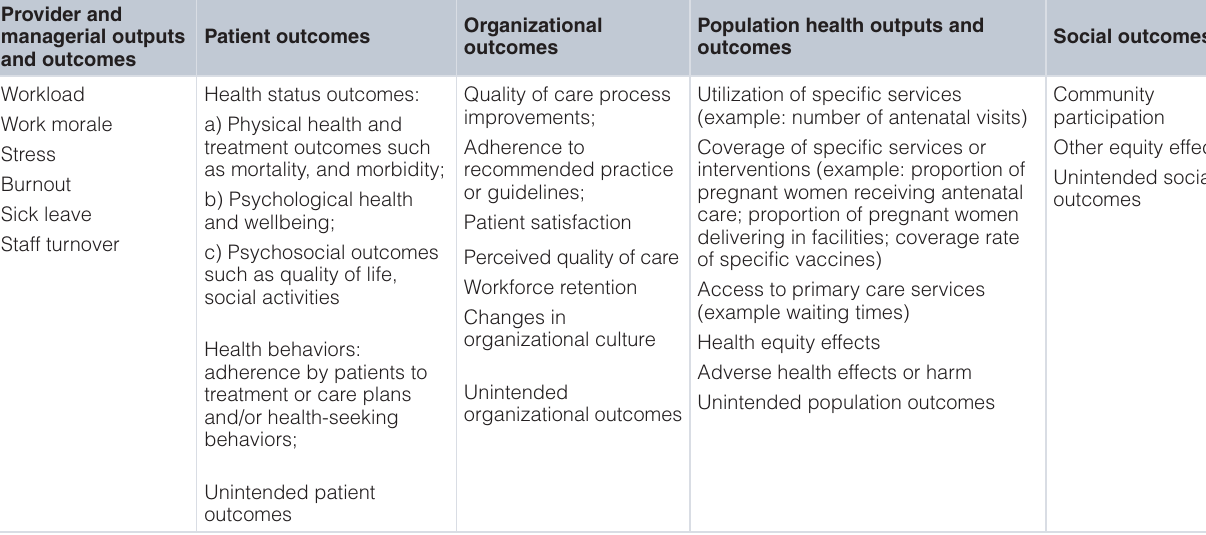
Table 2. Outcomes of relevance to users of the evidence gap map. Provider and managerial